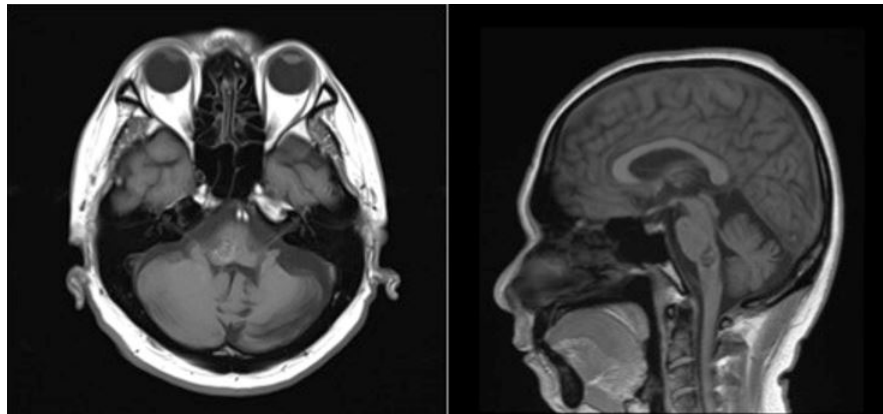
Figure 4: T1-weighted images from the patient’s cranial magnetic resonance imaging